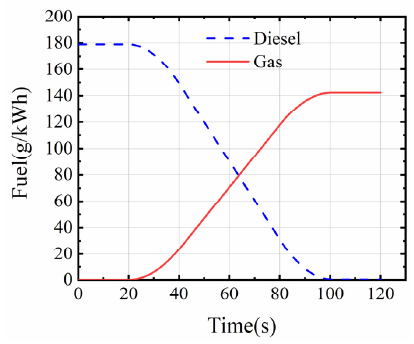
Figure 8. Fuel change curve.